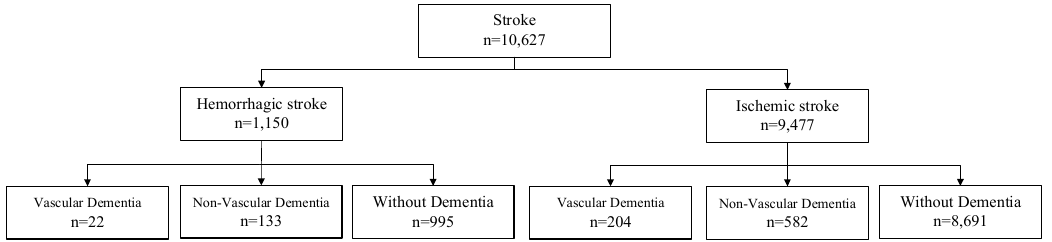
Figure 1. Stroke population in the study